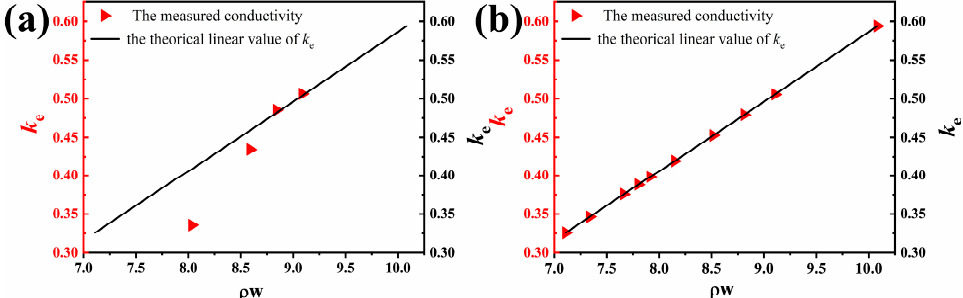
Figure 4. ρ w − k e curve of ( a ) Ag − SnO 2 composites and ( b ) Ag − La 2 Sn 2 O 7 composites. Figure 4. ρ w- k e curve of ( a ) Ag-SnO 2 composites and ( b ) Ag-La 2 Sn 2 O 7